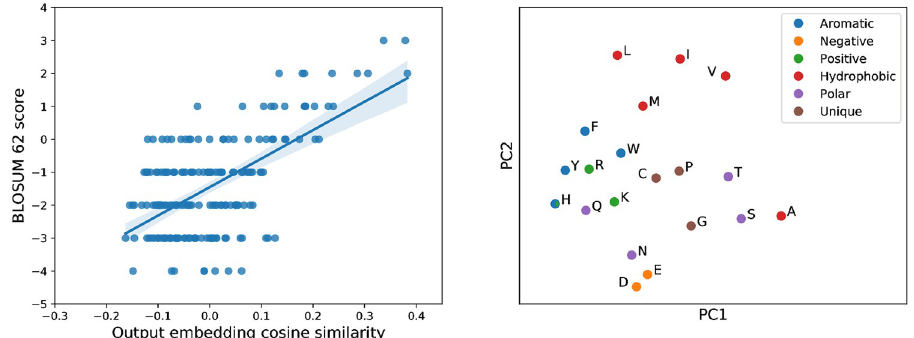
Fig 2. Amino acid representations learnt by VAE models capture biochemical properties. Left: pairwise cosine similarities between amino-acid output embeddings from an AR-VAE model trained on unaligned sequences correlate with amino acid substitution scores in the BLOSUM 62 substitution matrix (Spearman ρ = 0.423, n = 190); right: projection of AR-VAE output embedding weights onto first two principal components groups embeddings corresponding to biochemically related amino acids.